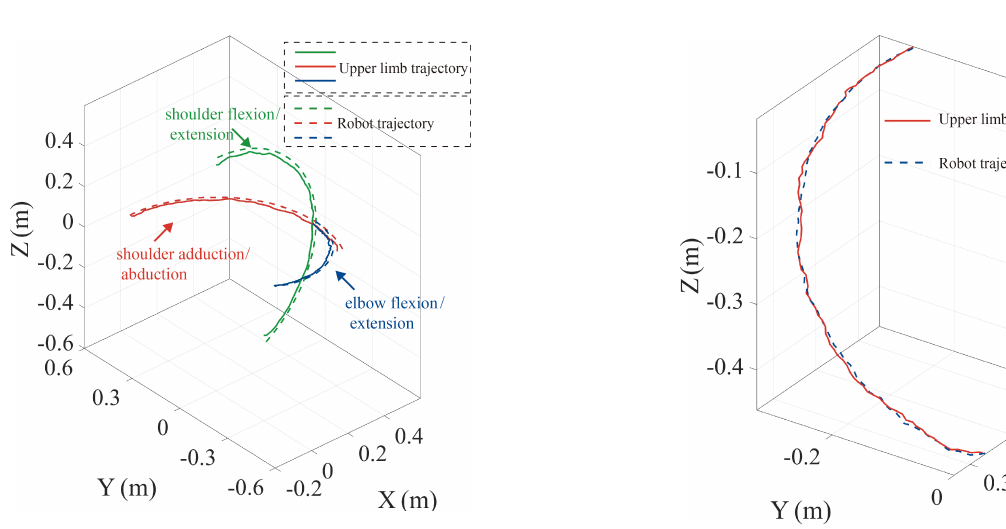
Figure 7. The upper limb trajectory and the robot trajectory in the multi-joint exercise